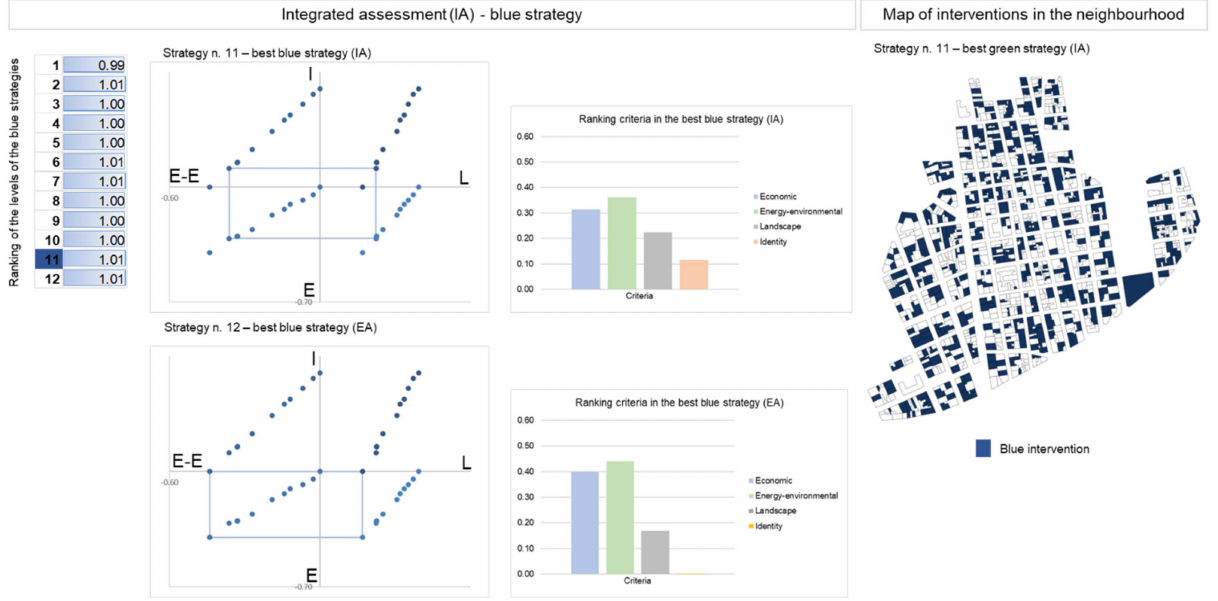
Figure 8. Ranking of the levels of the blue strategy based on the aggregate assessment; comparison between the two levels of the strategy in economic terms and the integrated assessment; visualization of the ranking of the criteria for the best economic level and the integrated evaluation; map displaying the best level of the blue